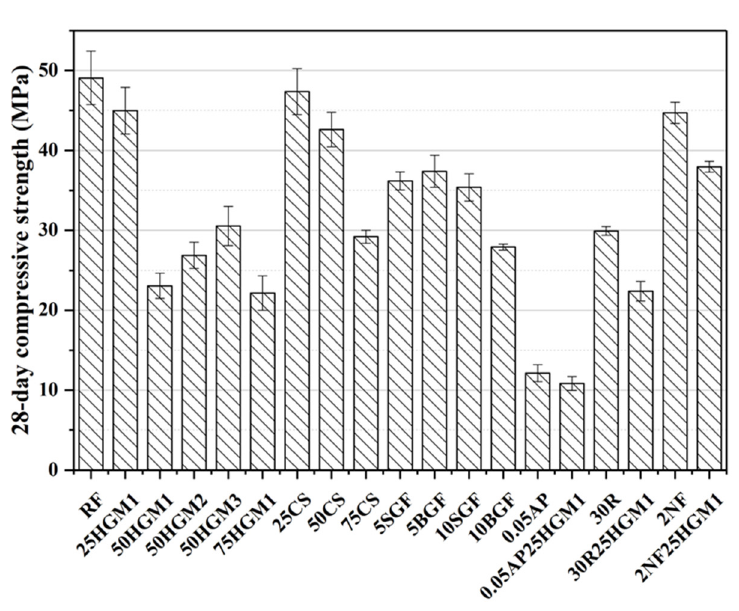
Figure 6. 28-day compressive strength of specimens.